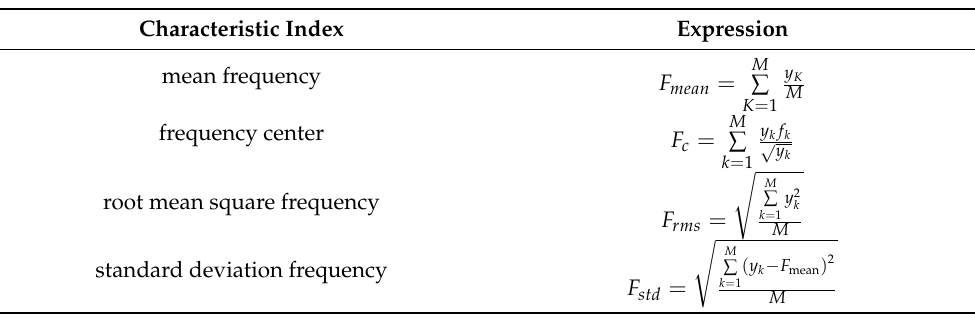
Table 7. Frequency domain characteristic